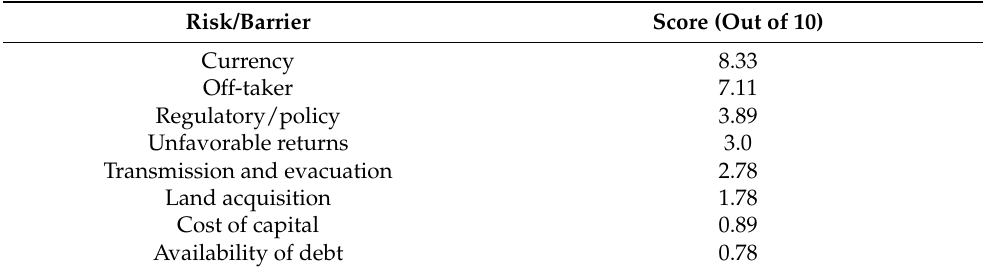
Table 2. Scoring of risks faced by investors in renewable energy projects in India